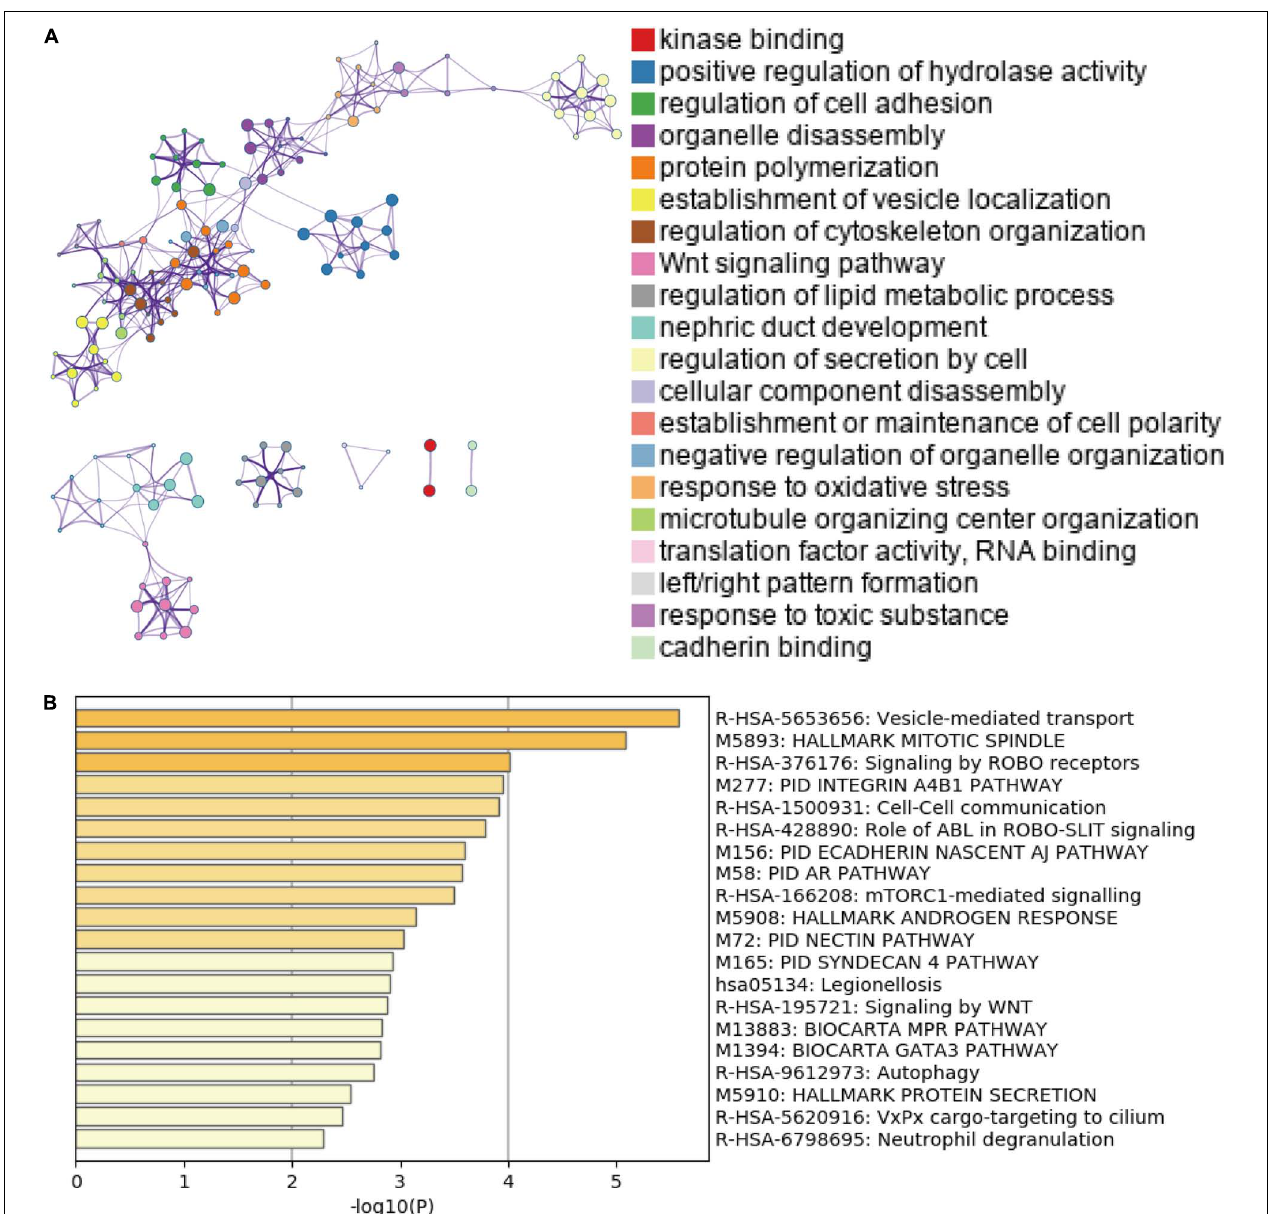
FIGURE 3 | Gene Ontology (GO) and pathway analysis. (A) GO annotation of DEAS covering kinase binding, regulation of hydrolase, and regulation of cell adhesion, etc. (B) KEGG pathway enrichment analysis of DEAS with enrichment